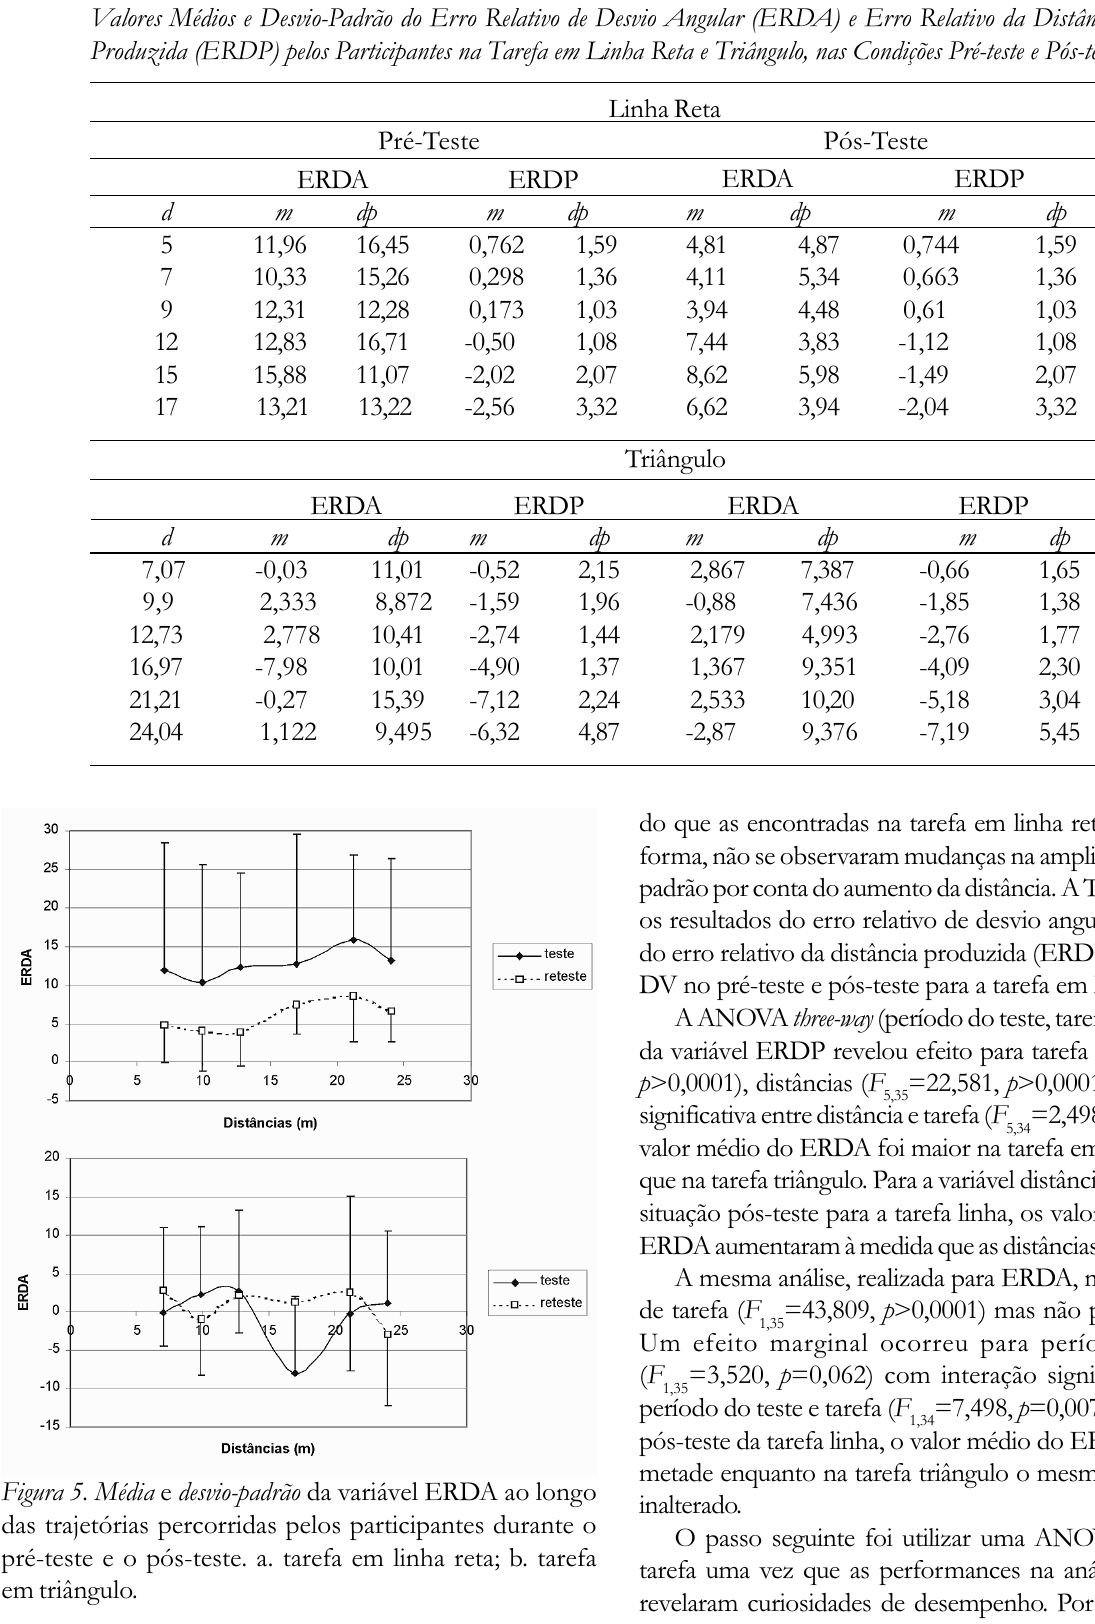
Psicologia: Reflexªo e Cr(cid:237)tica, 2004,